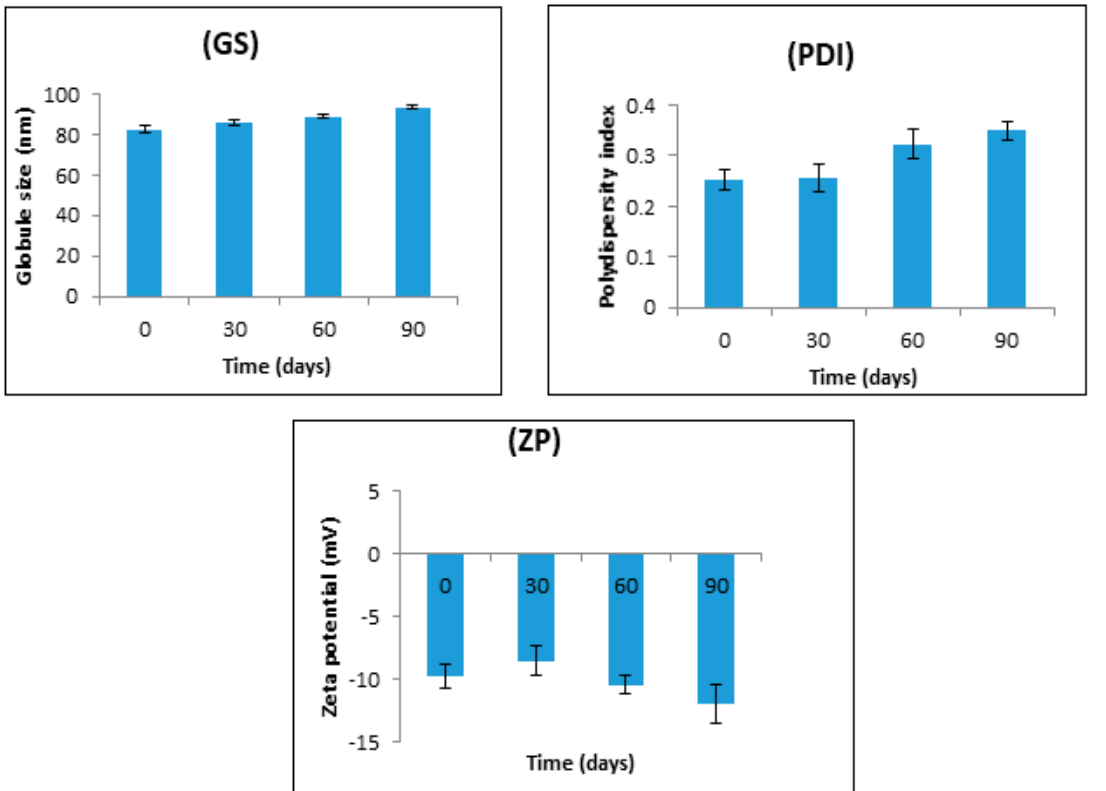
Figure 8. E ff ect of storage for up to three months at 40 ± 2 ◦ C and 75 ± 5% RH on the globule size (GS), polydispersity index (PDI), and zeta potential (ZP). The data are presented as the mean ± SD, n = 3. The slight increase in particle size, PDI, and ZP was not significant ( p > 0.05) for adjacent sampling points.